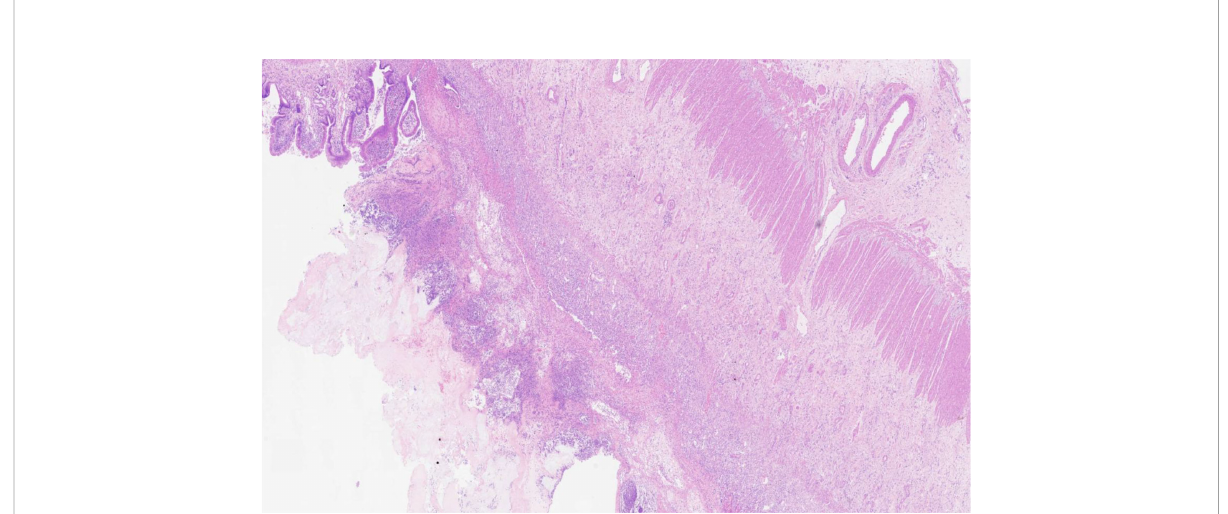
FIGURE 4 Histological examination showed crypt loss, marked in fl ammation, and associated architectural distortion (hematoxylin and eosin,